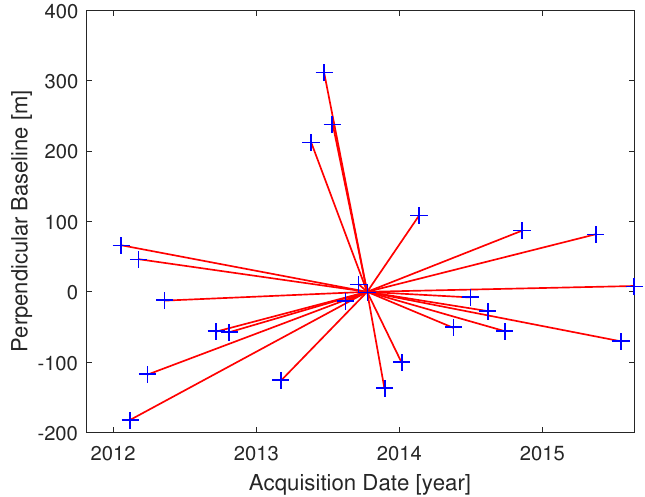
Figure 4. Acquisition date and perpendicular baseline